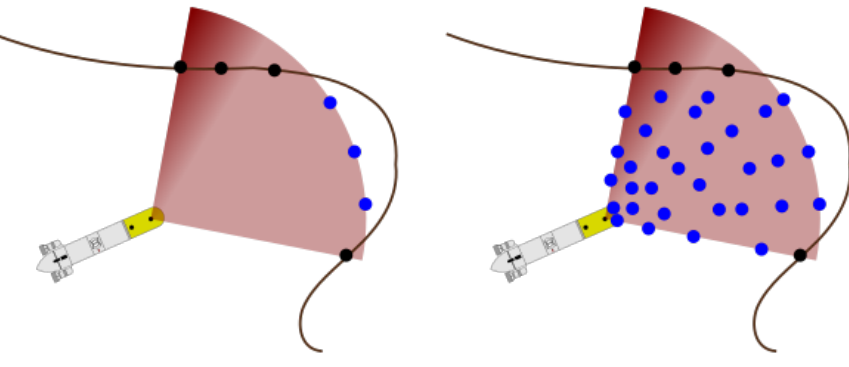
Figure 3. ( left ) Original range measurements made with a sonar. ( right ) Sampled points for map learning (black points are occupied and blue points are free).